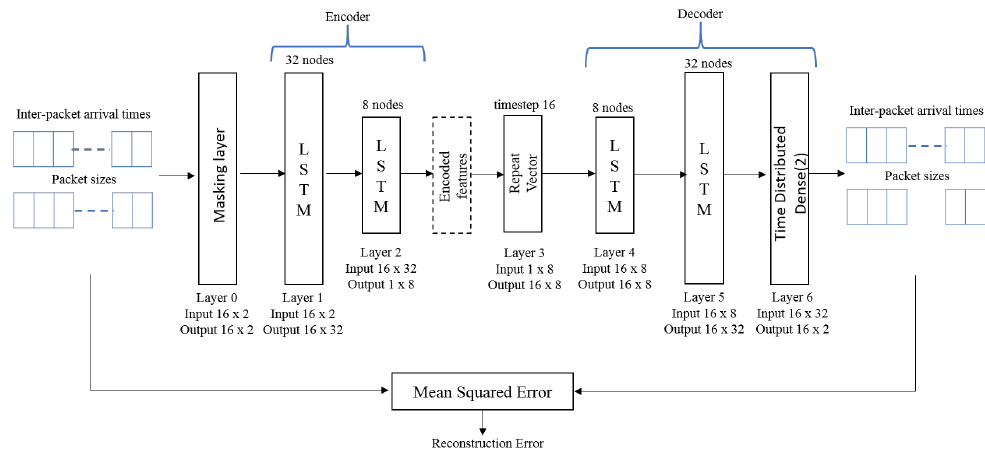
Figure 3. LSTM Autoencoder for DDoS flow